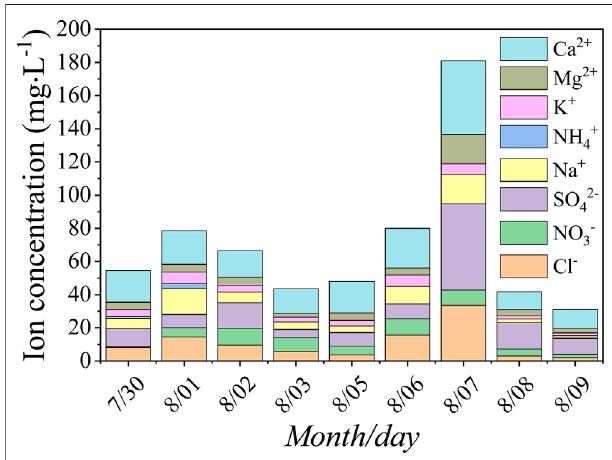
FIGURE5| Temporalvariationsintheconcentrationsofchemicalionsin meltwater samples in